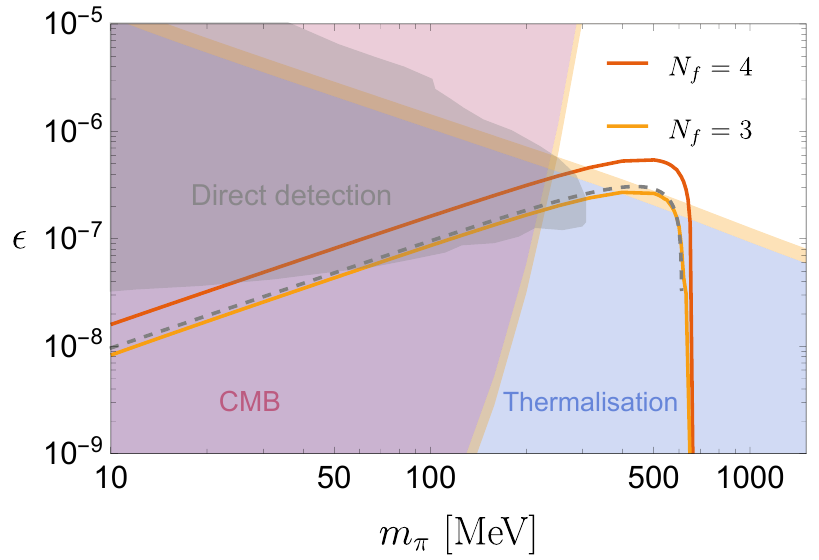
Figure 2. Constraints on the kinetic mixing parameter and dark pion mass in the resonant SIDM scenario. The coloured (numerically) and dashed (estimate eq. (6.3)) lines show the values of (cid:15) for which the correct DM relic density is produced, and for which the dark pions have the required self-interaction. The blue shaded area excludes those values of (cid:15) for which the dark photon cannot maintain kinetic equilibrium with the SM. The purple shaded area depicts the CMB constraint on DM annihilations. The grey shaded area is excluded from beam dump searches from E137, nuCAL and CHARM. The exclusion bounds are slightly stronger for N f = 3 (indicated by the orange shaded areas) as the dark charge is smaller for N f = 3 (eq.